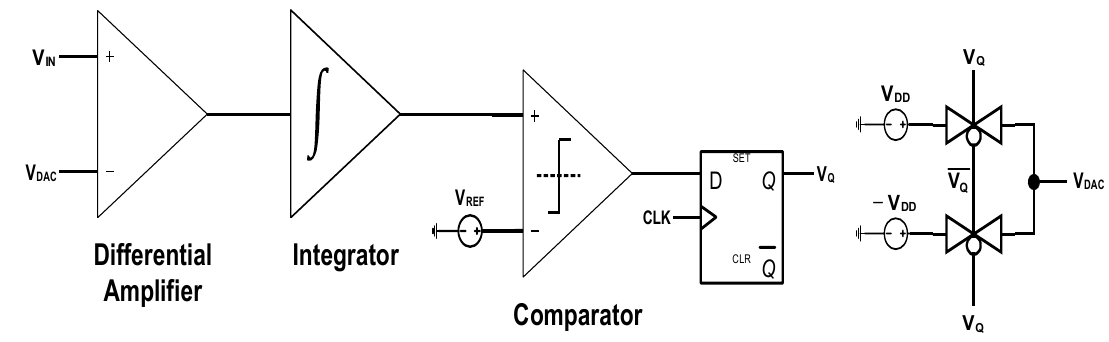
Figure 2. The delta-sigma modulator